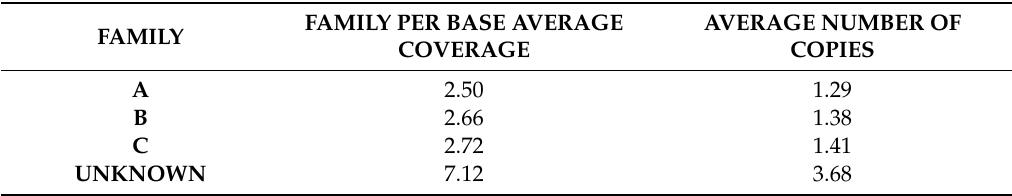
Table 2. Mapping results of the sunflower nuclear genomic reads onto the total collection of putative CACTA elements.